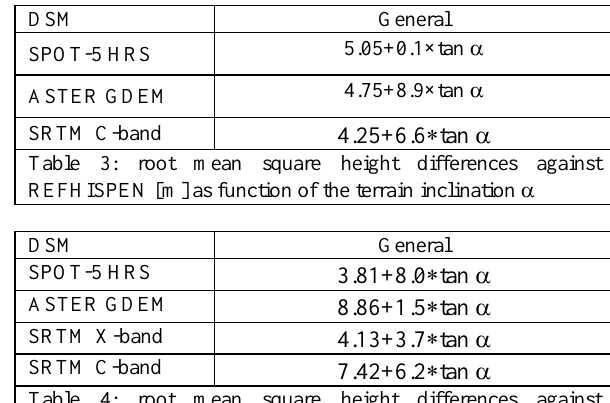
Table 4: root mean square height differences